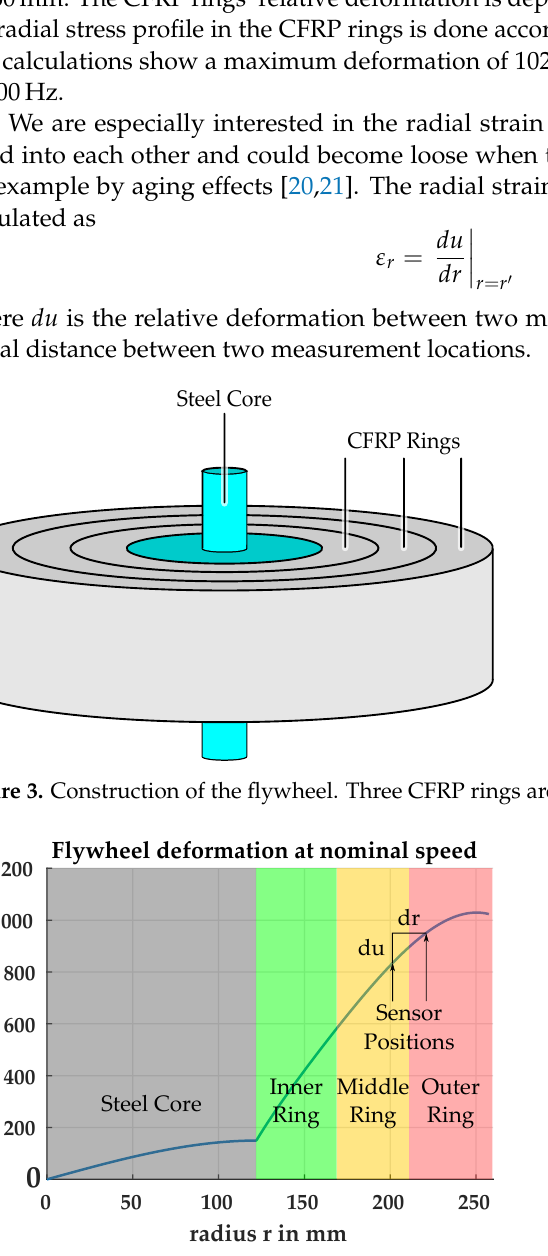
Figure 4. Flywheel ring layout and deformation at nominal speed. The relative deformation decreases with radius. The interface between the middle and outer ring was chosen for calculating the accuracy requirements because it is the point of interest with the lowest relative deformation and therefore the worst case